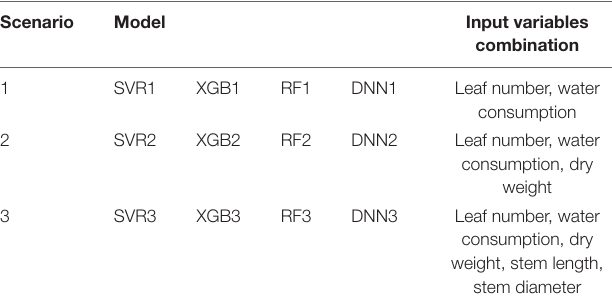
TABLE 2 | Summary of the combination of the input variables for the applied